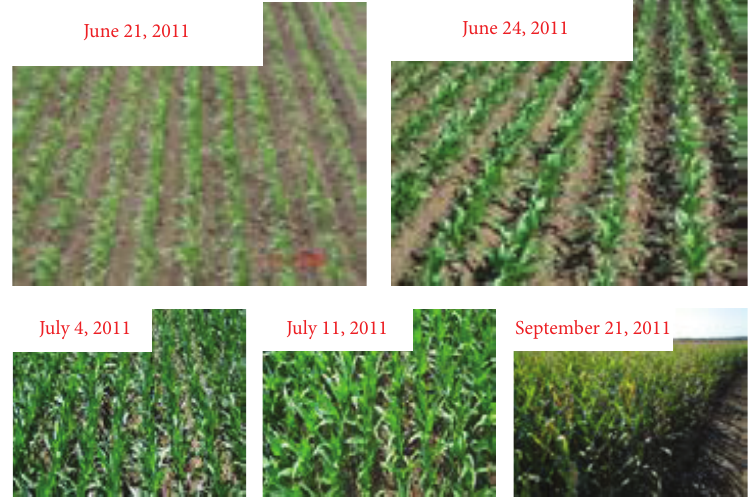
Figure 4: Corn canopy in different growth stages.